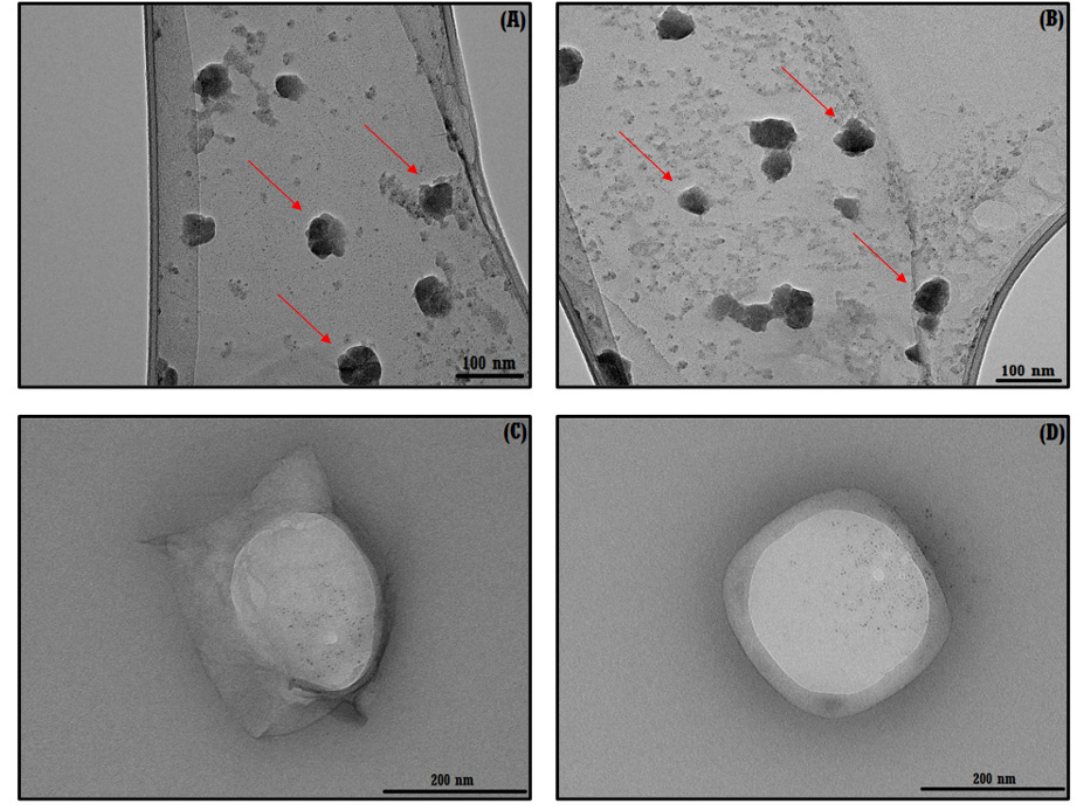
Figure 6. TEM images of NSs ( A , B ), NSs–MPH ( C ), and NSs–CUR ( D ). The red arrows ( A , B ) highlight some of the synthesized NSs.